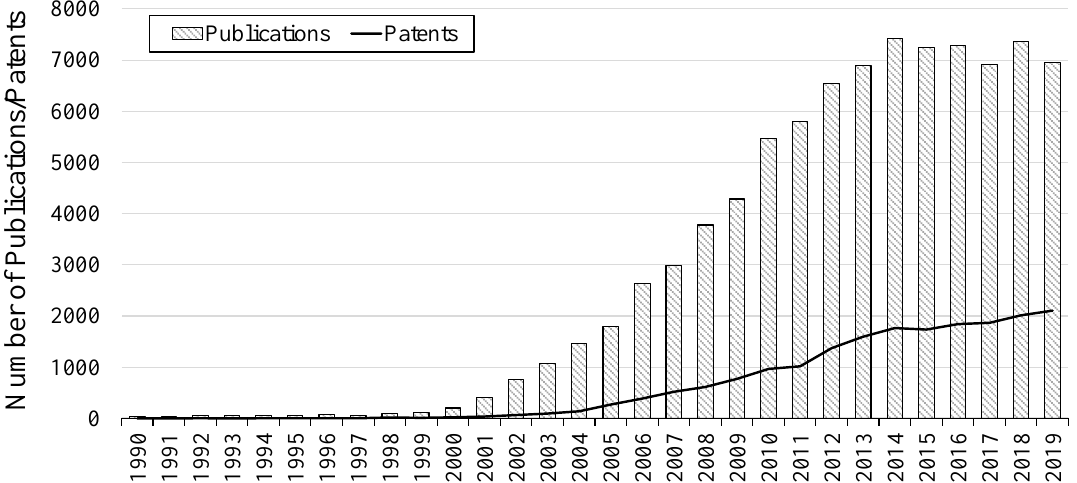
Figure 3. The number of publications and patents each year from 1990 to 2019, found in the SciFinder TM database containing the concept “ionic liquid”. The addition of further keywords, such as “room temperature molten salt”, was found to be insignificant.